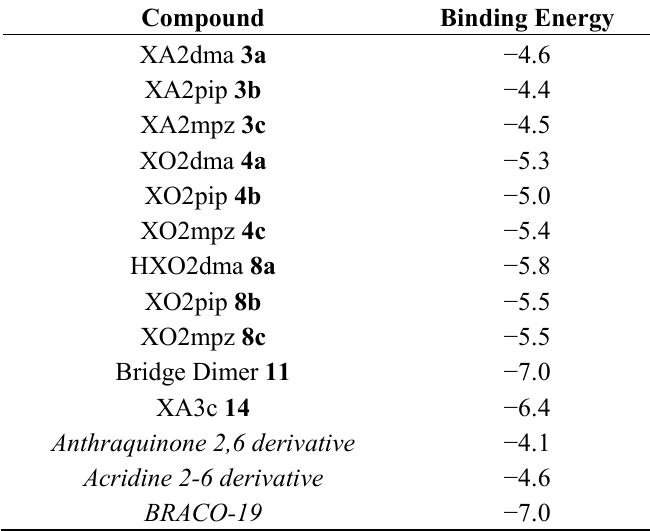
Table 1. Docking binding energies (kcal/mol) for different compounds with 1KF1. The rmsd values for the whole complex are <4